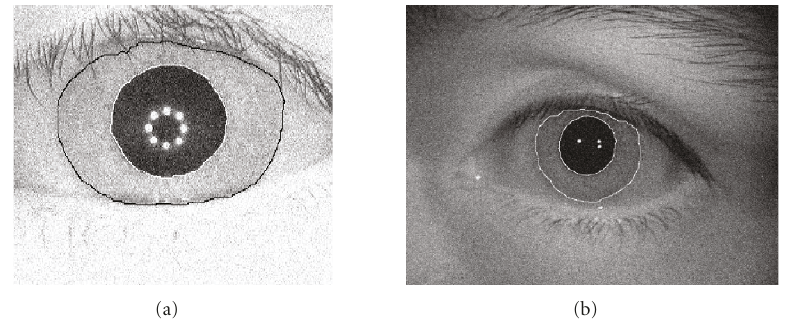
Figure 10: Performance of proposed algorithm in presence of Gaussian noise. For both images we have added a Gaussian white noise with mean = 0 and variance = 0.007.